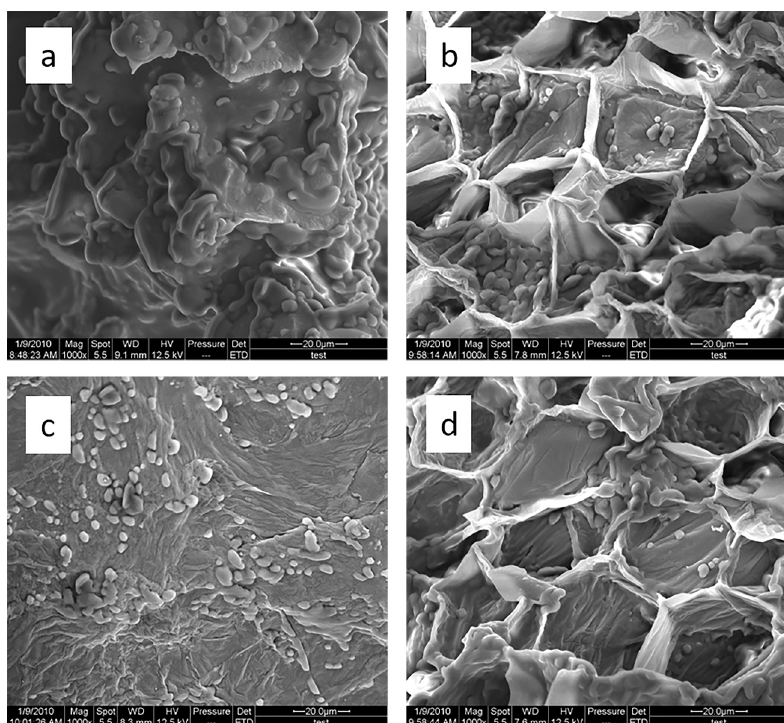
Figure 7. SEM images of S. chinensis fruits. ( a ) S. chinensis fruit raw materials, ( b ) S. chinensis fruits treated by ultrasound digestion, ( c ) S. chinensis fruits treated by microwave digestion, and ( d ) S. chinensis fruits treated by alternate ultrasound/microwave digestion.